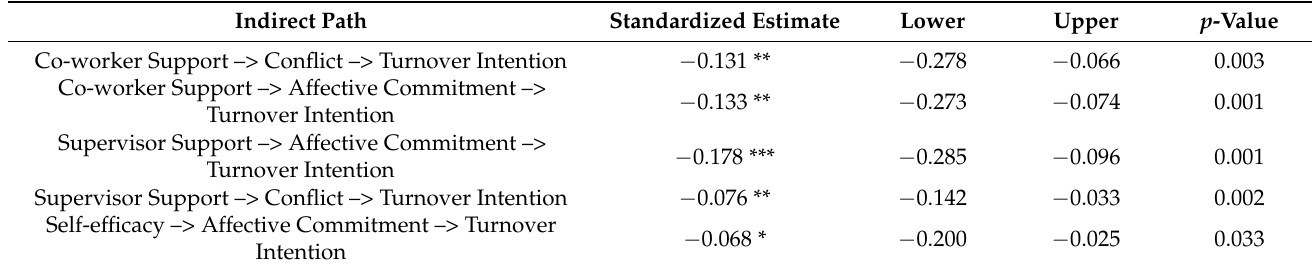
Figure 1. Empirical Model. Table 2. Indirect